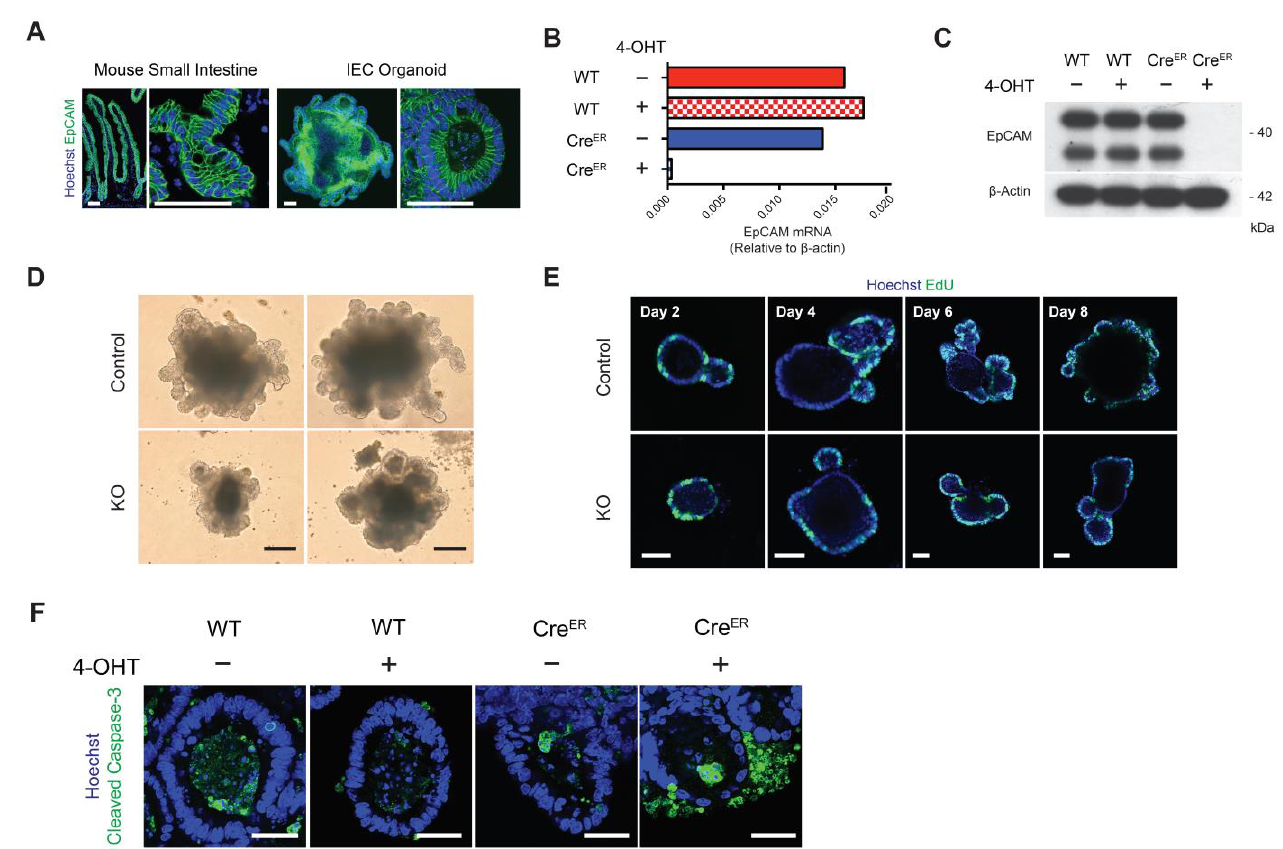
Figure 1. Generation and characterization of Epithelial Cell Adhesion Molecule (EpCAM)-deficient organoids. ( A ) Immunofluorescence microscopy confirming EpCAM expression in mouse small intestine in vivo and intestinal organoids in vitro. EpCAM (green). Bars = 50 μ. ( B ) qPCR demonstrating that EpCAM mRNA is efficiently deleted in KO organoids (normalized to β-actin). ( C ) Silencing of EpCAM protein expression in KO organoids demonstrated by Western blotting. ( D ) Phase contrast photomicrographs of control (untreated ROSA26-Cre ERT2+ EpCAM fl/fl ) and KO (4-OHT-treated ROSA26-Cre ERT2+ EpCAM fl/fl ) organoids. Bars = 100 μ. ( E ) Assessment of cell proliferation in control and KO organoids after EdU incorporation and fluorescence microscopic detection using Click-iT methodology. Alexa Fluor 488-conjugated EdU (green). Bars = 50 μ. ( F ) Apoptosis in control and KO organoids. Cleaved Caspase-3 (green) detected via immunofluorescence microscopy. Bars = 25 μ. Nuclear counterstaining, Hoechst 33342 (blue) in ( A , E , F ).